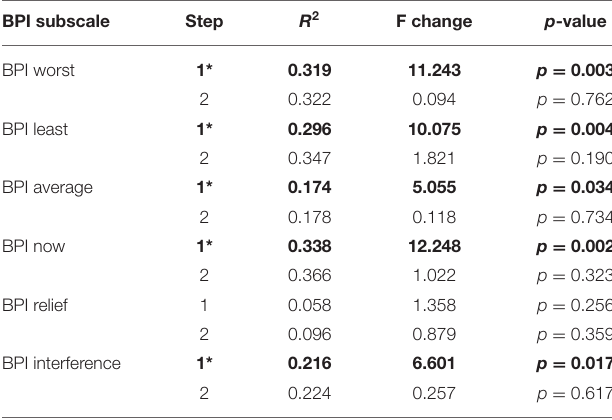
TABLE 10 | Stepwise linear regression of Brief Pain Inventory (BPI) with methylation (step 1) and IL2 (step 2). BPI